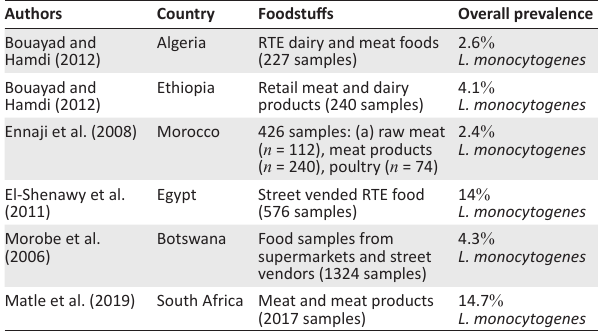
TABLE 3: Prevalence of Listeria monocytogenes in foods in